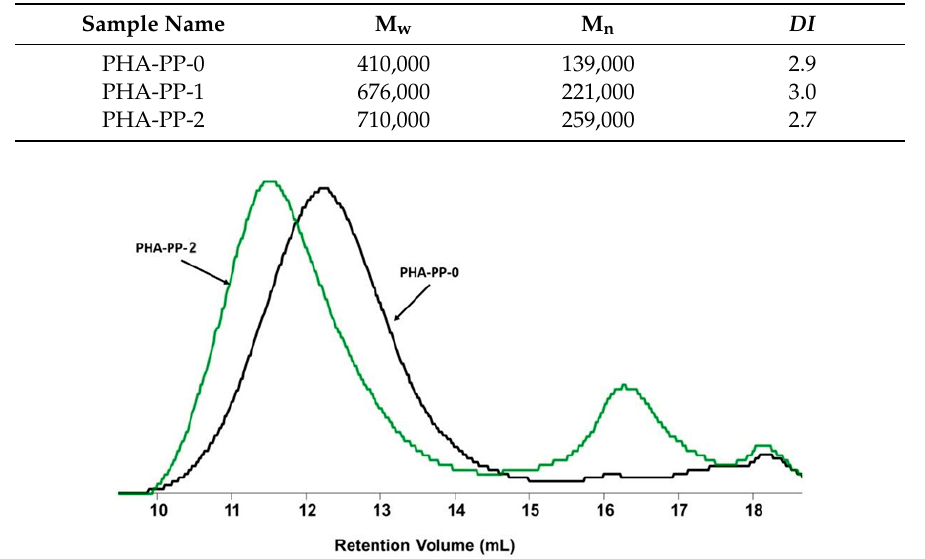
Figure 6. The comparison of the GPC traces of PHA samples produced from PP-0 and PP-2 with TSB by C. necator after 48 h.